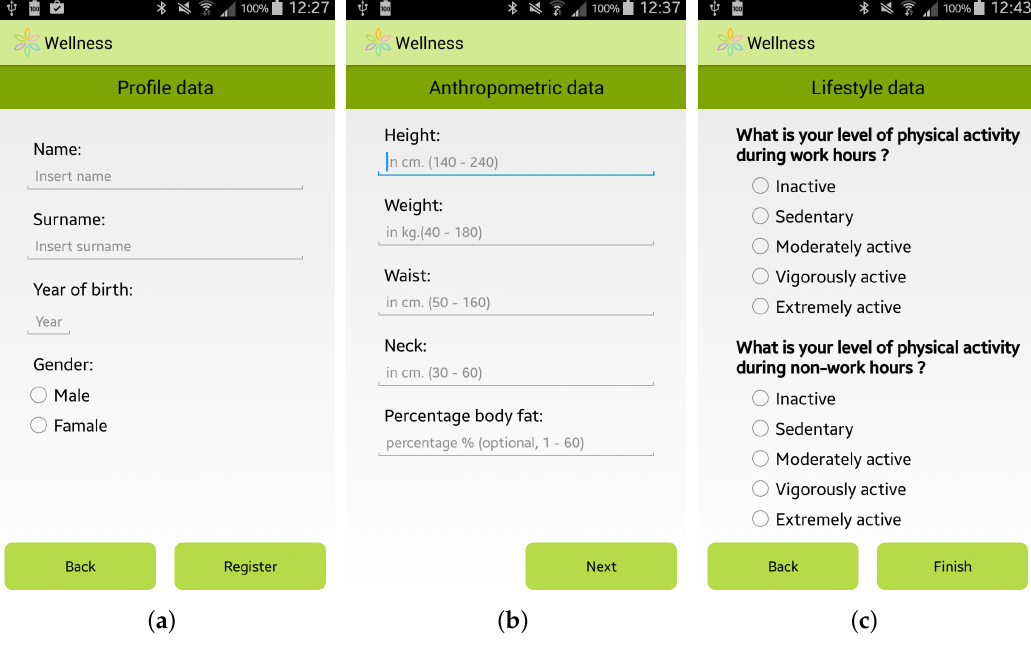
Figure 2. Screenshots of the Wellness App: ( a ) General Information; ( b ) Anthropometric Information; and ( c ) Lifestyle